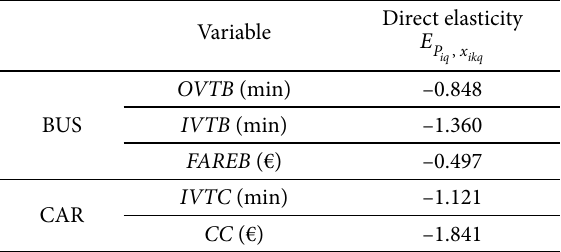
Table 9. Direct elasticities of Bus vs. Car Direct elasticity Variable